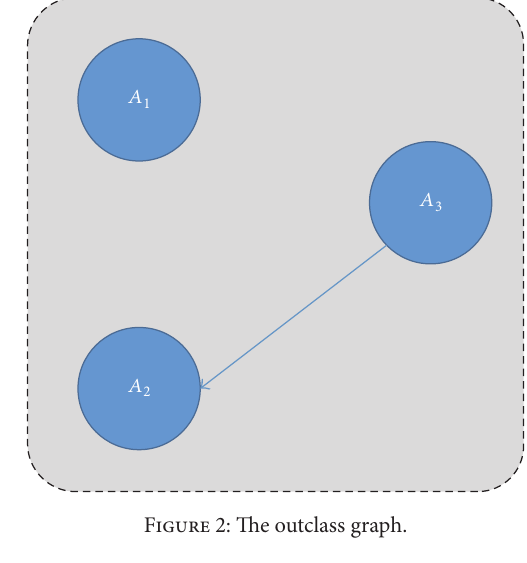
Figure 2: The outclass graph.